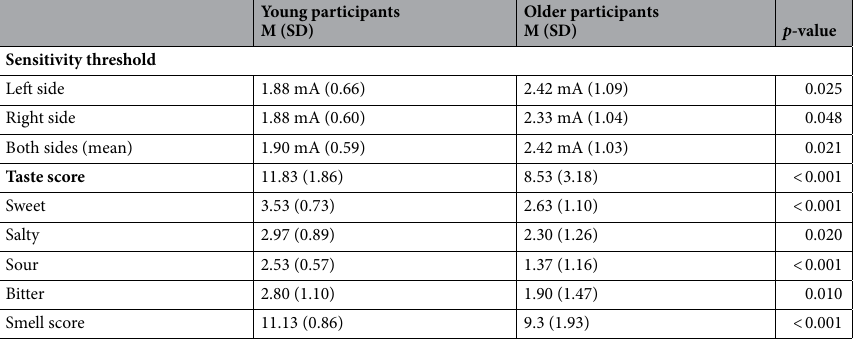
Table 2. Differences in sensitivity thresholds and taste as well as smell scores between groups ( n = 30 in each group). Differences between groups were assessed using independent t tests. No differences were observed between the sensitivity threshold of the left and right side in the young, t (28) = 0.12, P = 0.904, or the older group, t (28) = 0.21, P = 0.833.